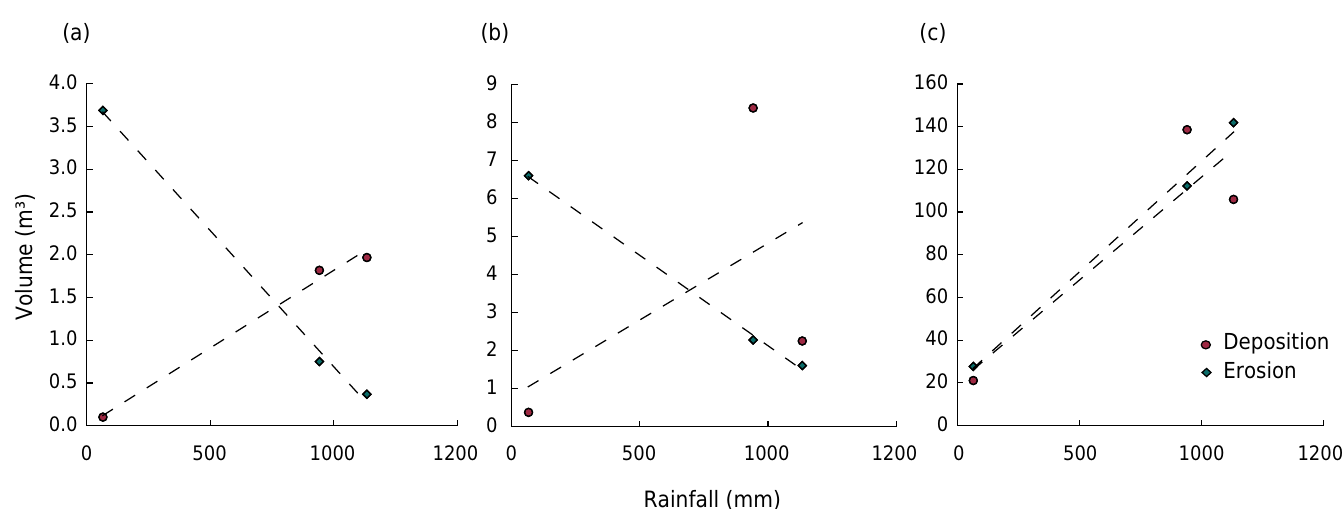
Figure 4. Correlation between erosion and deposition volume and accumulated rainfall. R: deep rills (a); GS-I: small gullies (b); and GS-II: large gullies